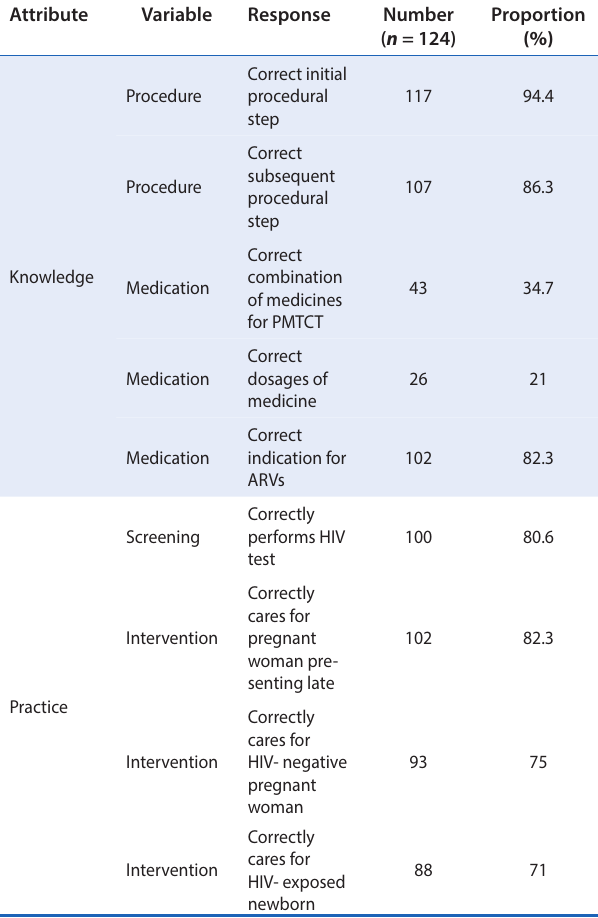
Table 2: Respondents’ knowledge and practice of PMTCT programme Attribute